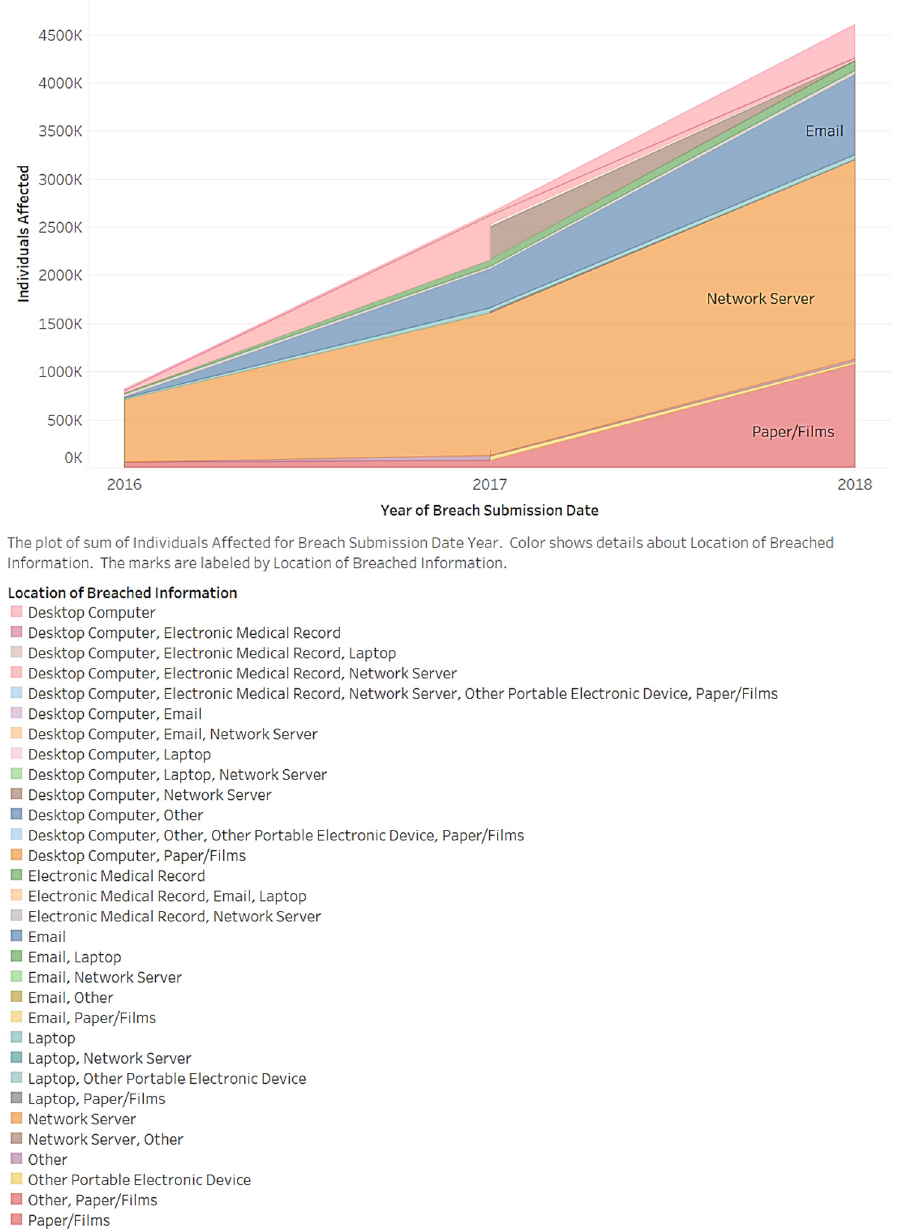
Figure 14. Trends related to the location of breached information.